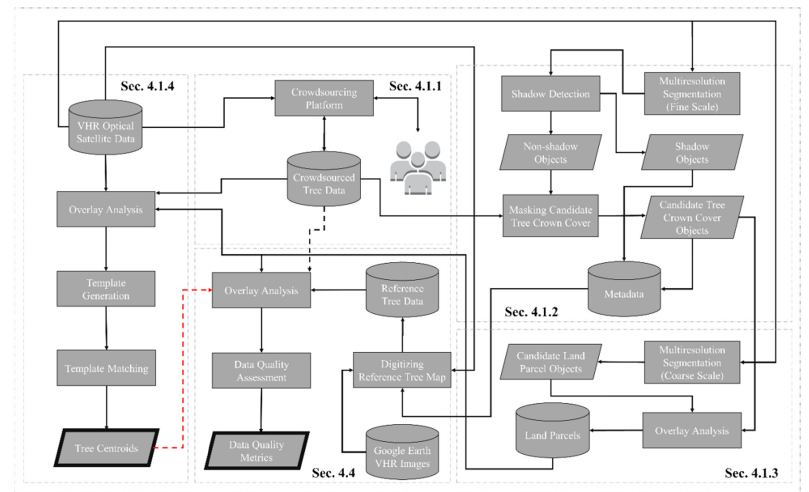
Figure 2. The proposed approach for ITC detection (based on collective sensing) and data quality assessment in this study.